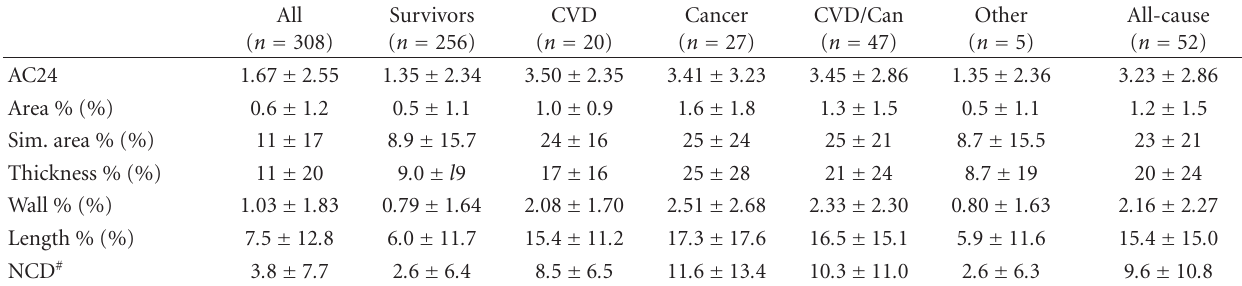
Table 3: The mean ± one standard deviation of all the imaging markers stratified for the di ff erent subsets of patients. NCD # stands for number of